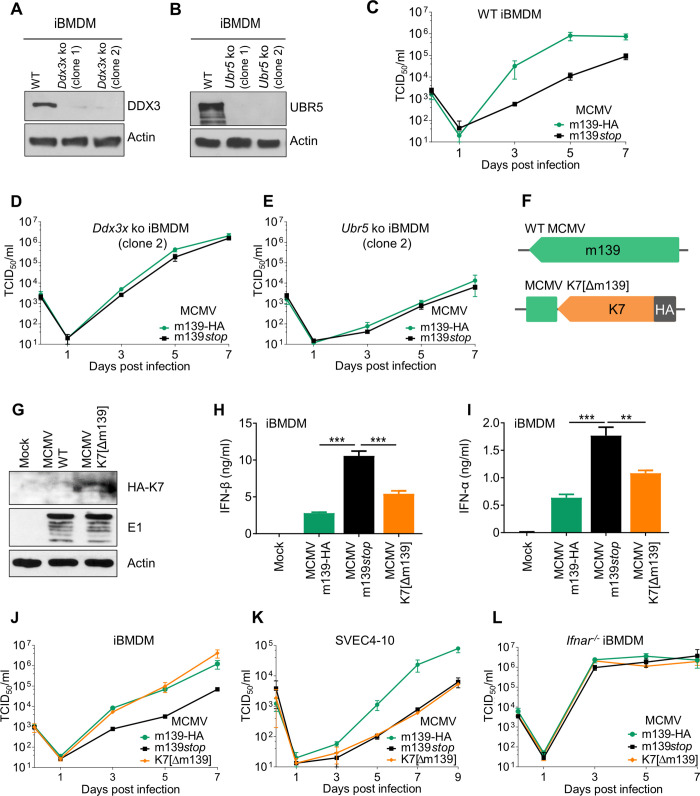
Modulation DDX3-mediated IFN signaling by m139 is crucial for efficient replication in macrophages.(A, B) Ddx3x and Ubr5 ko iBMDM (two independent clones each) were generated by CRISPR/Cas9 gene editing. DDX3 (A) and UBR5 (B) expression was verified by immunoblot analysis. (C, D, E) For multistep replication kinetics, WT (C) Ddx3x (D) and Ubr5 (E) ko iBMDM were infected with MCMV m139-HA or MCMV m139stop (MOI = 0.025). At different days post infection, supernatants were collected for titration. Viral titers are shown as means ±SD of three biological replicates. MCMV replication kinetics on the other Ddx3x and Ubr5 ko cell clones are shown in S5 Fig. (F) Schematic representation of WT MCMV and MCMV K7[Δm139], a substitution mutant expressing HA-tagged VACV K7 instead of m139. (G) 10.1 fibroblasts were infected with WT MCMV or K7[Δm139] (MOI = 5). Cell lysates were collected 24 hpi, and HA-K7 and E1 were detected by immunoblot analysis. (H, I) iBMDM were infected with MCMV m139-HA, m139stop, or K7[Δm139] (MOI = 0.1). At 16 hpi, IFN-β and IFN-α levels in the supernatant were measured by ELISA. Means ±SD of three biological replicates are shown. (J) For multistep replication kinetics, iBMDM were infected with MCMV m139-HA, m139stop, or K7[Δm139] (MOI = 0.025). Viral titers in the supernatant are shown as means ±SD of three biological replicates. (K, L) Multistep replication kinetics in (K) SVEC4-10 endothelial (MOI = 0.01) and (L) Ifnar-/- iBMDM (MOI = 0.05) with the same viruses as in J.